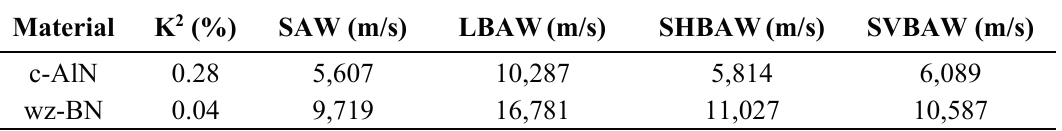
Table 1 . Electromechanical coupling and phase velocity of the Rayleigh-like SAW, phase velocities of the longitudinal (LBAW), shear vertical (SVBAW) and shear horizontal (SHBAW) bulk acoustic waves propagating along the <100> direction of AlN and wz-BN